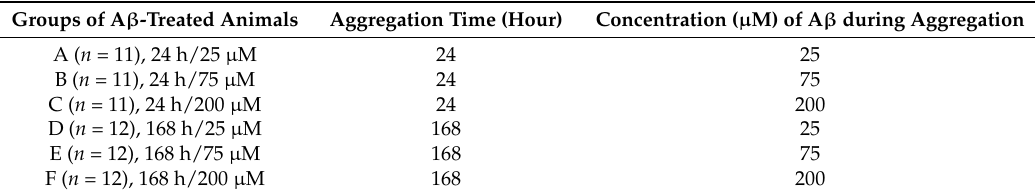
Table 1. Variation of aggregation time and concentration for systematic studies of the effect on toxic A β 1-42 aggregates used in biological experiments.